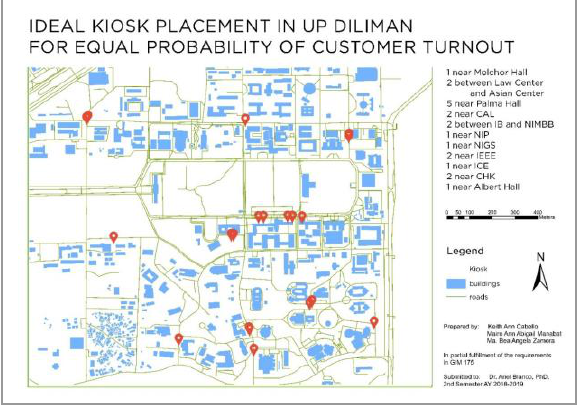
Figure 3. Map of the ideal kiosk locations.